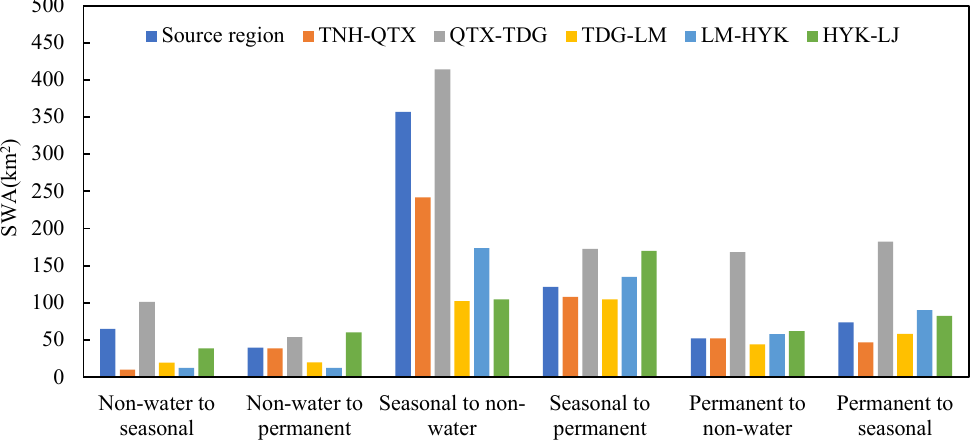
ISPRS Int. J. Geo-Inf. 2022 , 11 , x FOR PEER REVIEW Figure 12. The spatial pattern of the conversion of surface water bodies from 1986 to 2019 in the YRB.